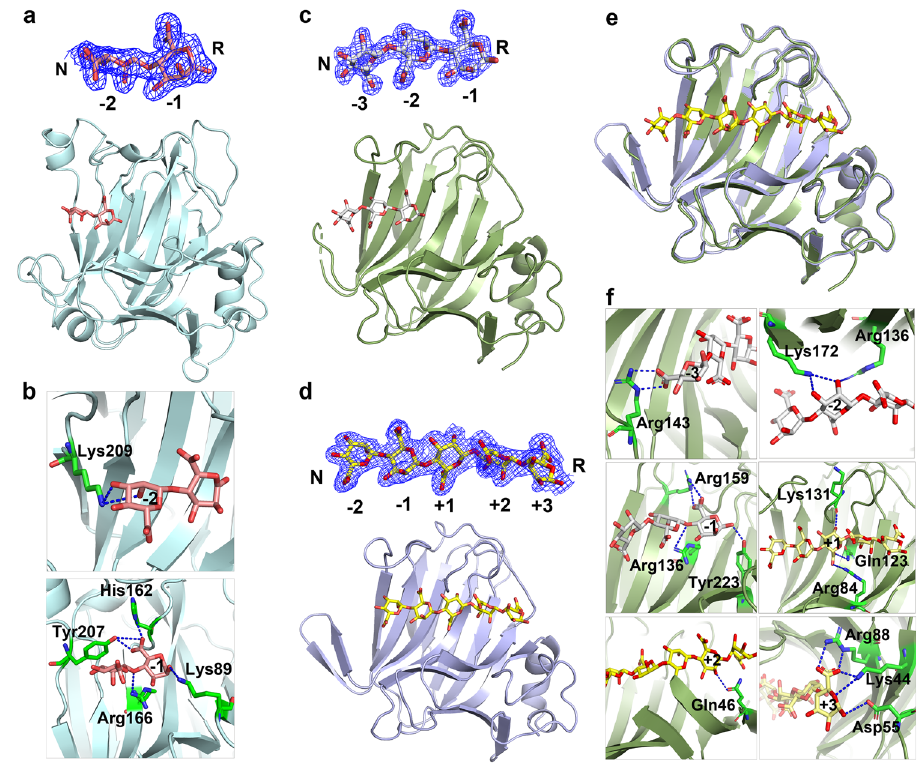
Fig. 2 Structural analysis of the AlyV R91A -M8, PyAly H125A -M8 and PyAly H125A_Y223A -M5 complexes. Overall structures of the a AlyV R91A -M8 complex, c PyAly H125A -M8 complex and d PyAly H125A_Y223A -M5 complex. AlyV R91A , PyAly H125A and PyAly H125A_Y223A are shown as cartoons in pale cyan, dark green and light blue, respectively. M8 and M5 are shown as sticks in salmon a , gray c , and yellow d , respectively. The electron density maps for M8 and M5 (contour level 1 σ ) are shown above the overall structures of the complexes. b Hydrogen bonding interactions between AlyV R91A and the sugar units at subsites -1 and -2. The residues involved in substrate binding are shown in sticks, and hydrogen bonds are indicated with blue dashed lines. e Structural comparison of the PyAly H125A -M8 complex with the PyAly H125A_Y223A -M5 complex. f Hydrogen bonding interactions between PyAly and the sugar units at subsites -3 to + 3. The residues involved in substrate binding are shown in stick, and hydrogen bonds are indicated with blue dashed